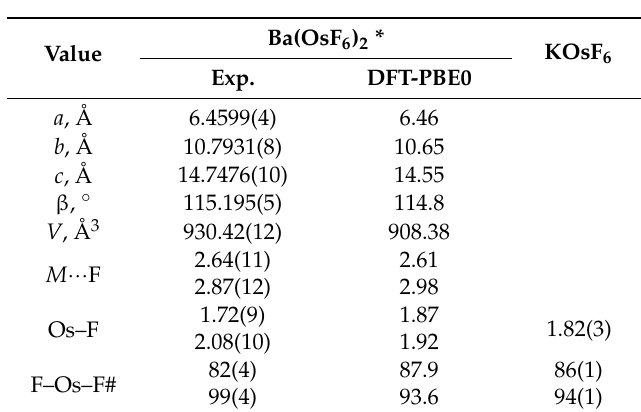
Table 1. Selected crystallographic data for Ba(OsF 6 ) 2 and KOsF 6 [8].